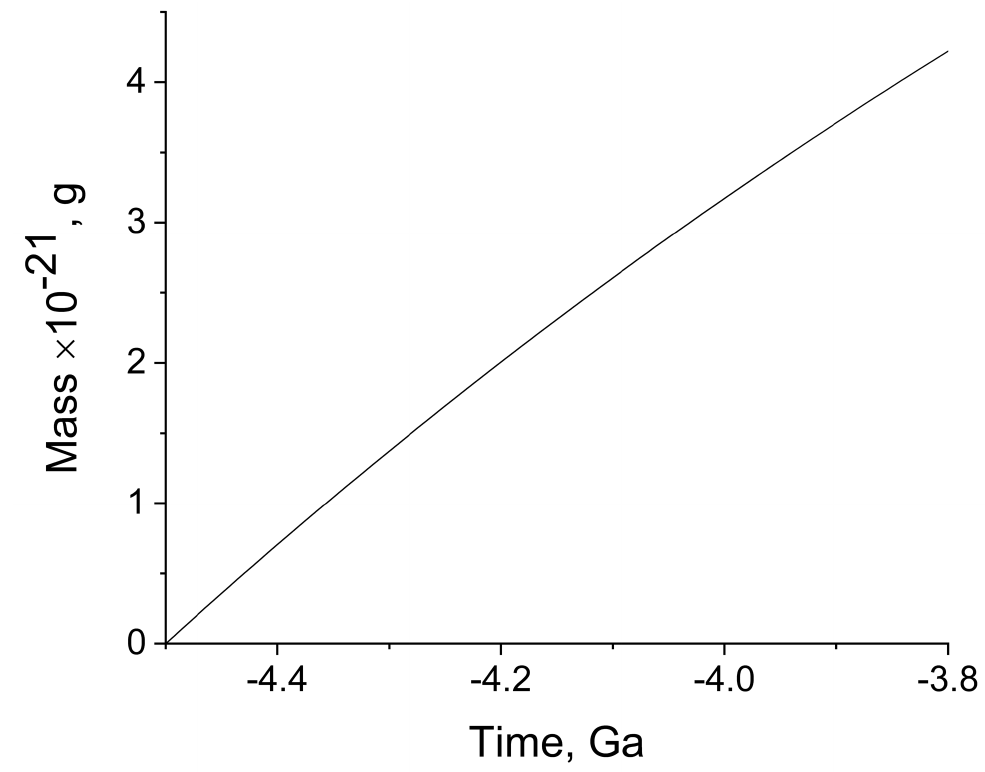
Figure 4. Accumulation of organic matter in the ocean upon the radiation-induced transformation of dissolved inorganic substances.